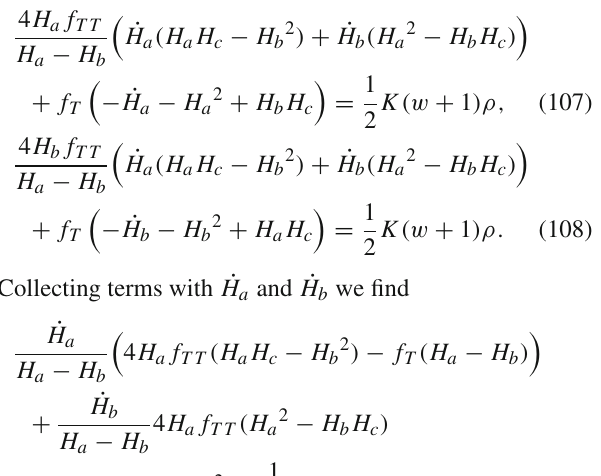
Fig. 6 The dependence ρ( T ) = − T − 5 f 0 T 3 f 0 = − 1 for the right plot and for both graphs K = 5